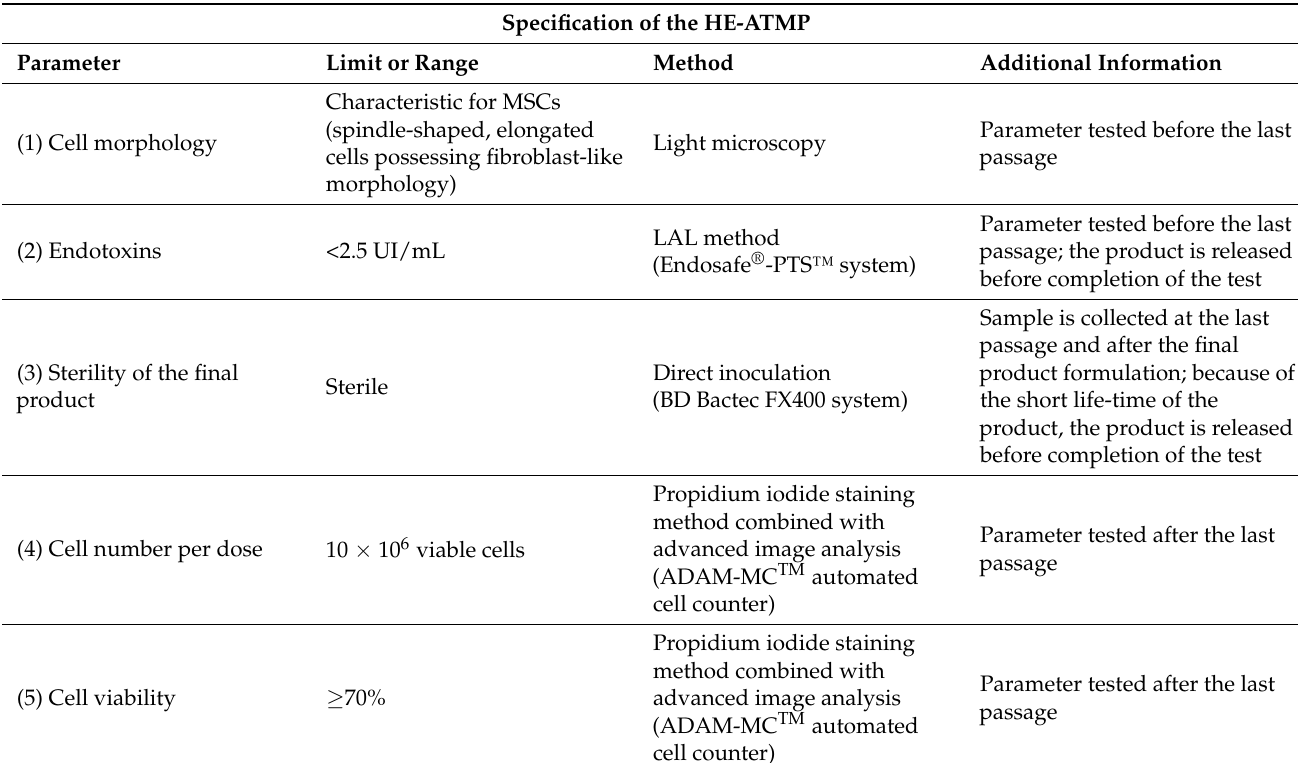
Table 2. Quality specification of the HE-ATMP. The parameters included in the table are the QCA of the final cell-based product.